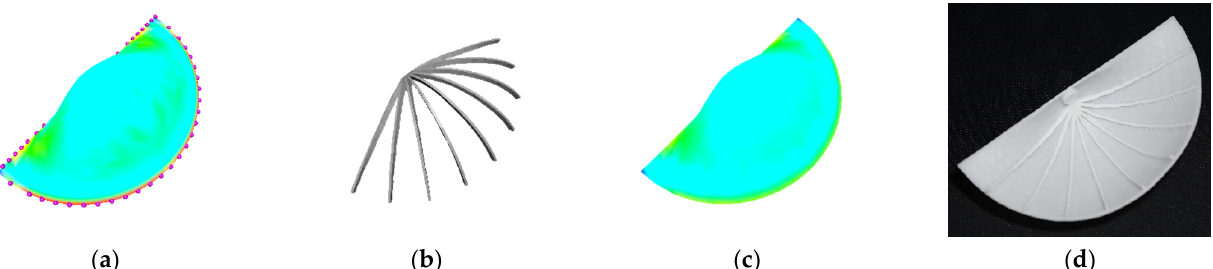
Figure 11. Unidirectionally stiffened snail, from left to right: ( a ) initial stress without stiffeners; ( b ) optimized stiffeners; ( c ) final stress with stiffeners; ( d ) 3D print.